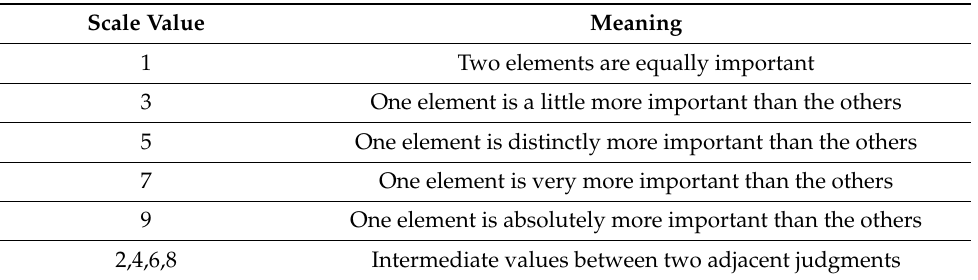
Table 4. Meaning of each scale value (Saaty scale)